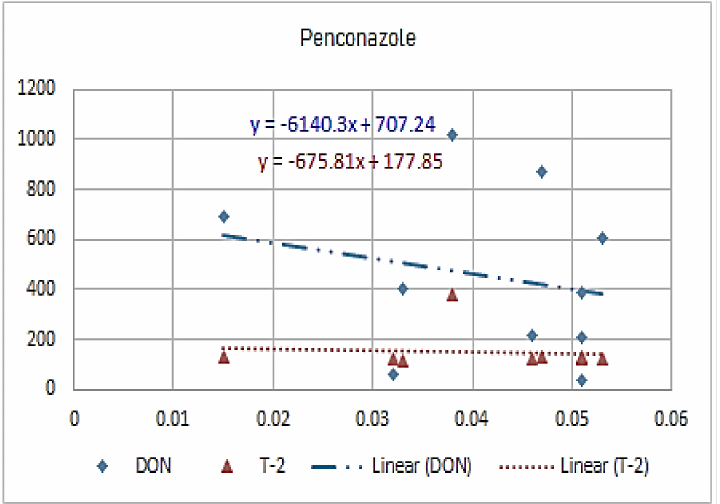
Figure 2. The relation between penconazole residue (ppb) and DON and T-2 toxin (ppb) in wheat